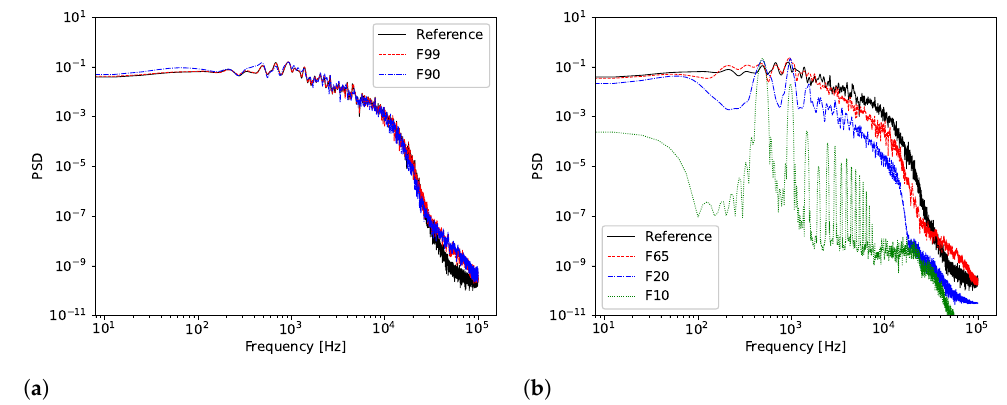
Figure 16. Power spectral densities of the axial velocity signal obtained from the isolated simulations of a probe located at the center of plane 40 (red plane of Figure 11). ( a ) F99, F90. ( b ) F65, F20, F10. Finally, and in order to illustrate the impact of the injected signals on the full LES predicted flow field, the static temperature distribution for all the nodes of plane 40 and for the 20,000 snapshots of the database is given in Figure 17. For the reference, as well as for cases F99 and F90 , a peak is observed at 300 K which corresponds to the injection temperature of the cold flow by the multiperforations. At the chamber/turbine interface, these extreme temperature values are still visible. The second peak is located at a value around 513 K (injection temperature of the hot flow of the plenum). For F65 , the peak at 300 K is hardly visible, and even disappears completely for cases F20 and F10 . This is simply due to the fact that the fluctuations imposed at the inlet are no longer sufficiently large to consider and capture this extremum. As the reconstruction becomes more and more incomplete, the width of the temperature distribution is reduced and the extreme values are no longer reached by the boundary condition